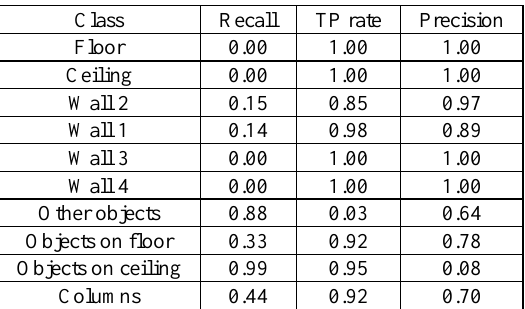
Table 2 . Accuracy metrics for the office space point cloud: Recall (false positive rate), True Positive (TP) rate and Precision.